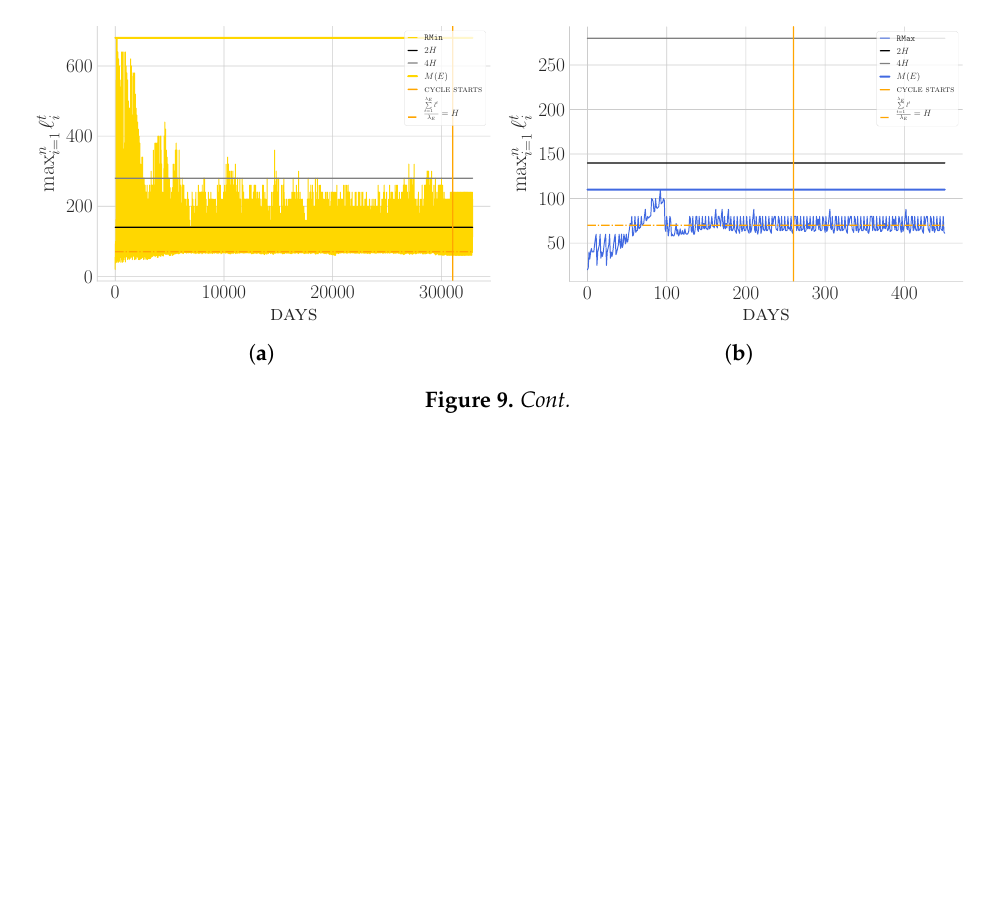
Figure 8. How maximum M ( E ) ( a ) and maximum λ E ( b ) change as a function of H when instances are induced by all partitions of H ∈ { 15,20,25,30,35 } having cardinality n = 15. Panels ( c , d ) show strategies that, experimentally, exhibit 2-approximation.